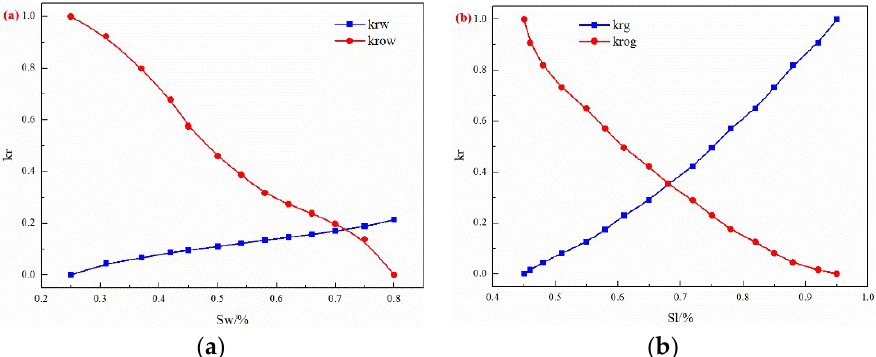
Figure 2. The phase permeability: ( a ) oil and water, ( b ) gas and liquid.